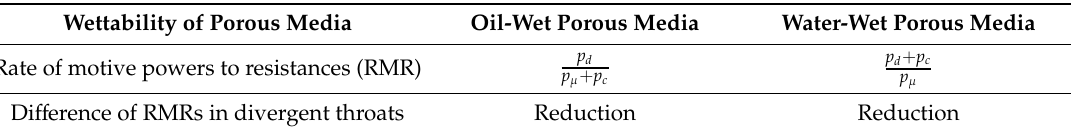
Table 1. The changing trend of the di ff erence of rate of motive powers to resistances (RMRs) in divergent throats with the increase of displacement fluid